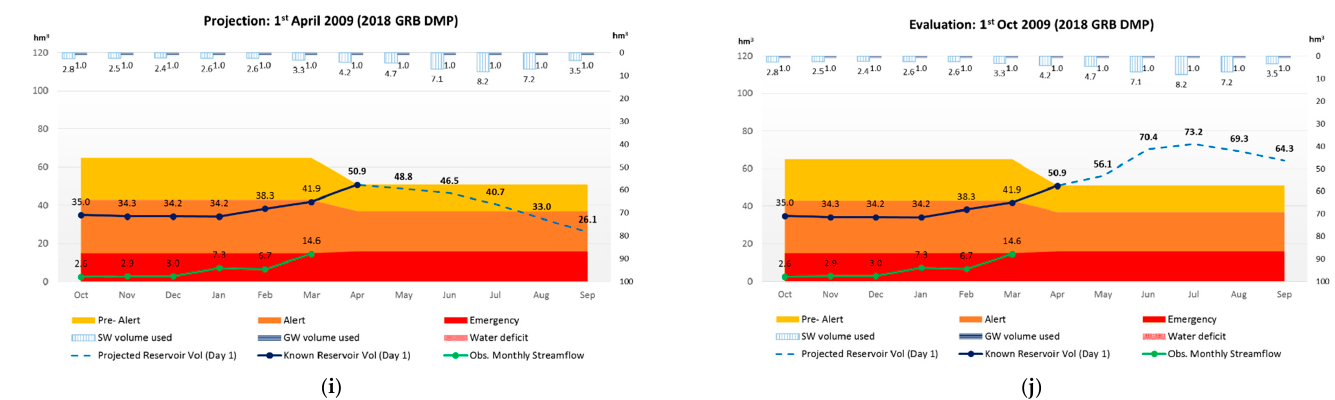
Figure 6. 2018 GRB DMP: Measures taken in April ( a,c,e,g,i ) and evaluation of the real situation made in October ( b,d,f,h,j ).